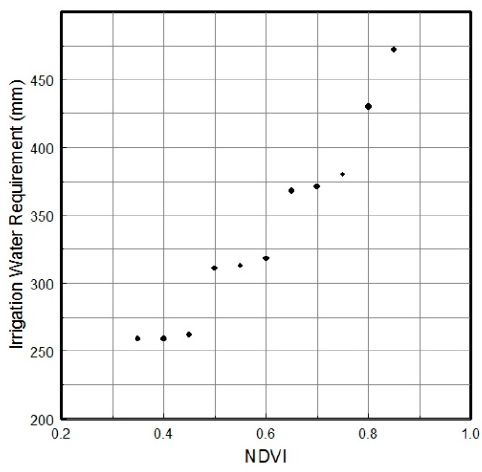
Figure 4. Water balance estimates of irrigation water requirement as per vegetation cover (NDVI) in